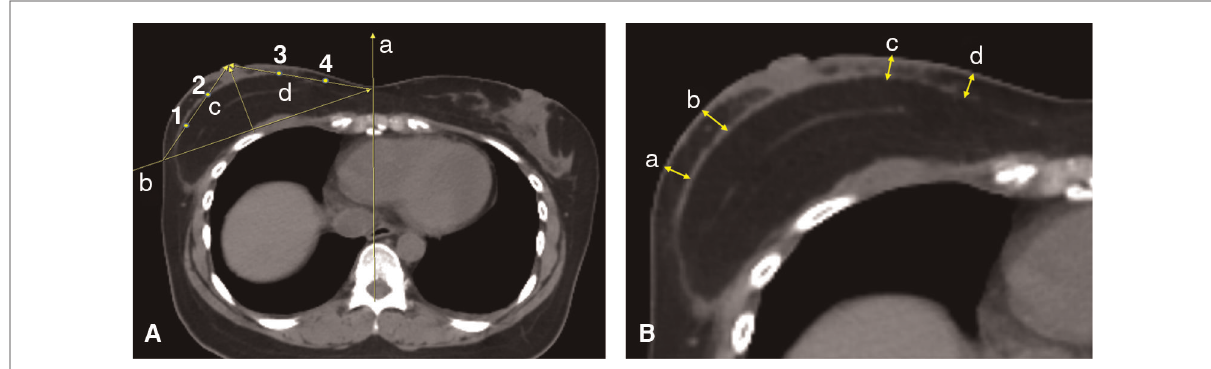
FIGURE 4 The graphical illustration of the fl ap thickness using CT scan: ( A ) (a) midsagittal line; (b) a line drawn from line “ a ” to the lateral pole of the breast through the outer surface of the rib cage; (c) a line connecting the center of the most projected point of the nipple to the crossing point of the line “ b ” with the breast skin at the lateral pole; (d) a line connecting the center of the most projected point of the nipple to the crossing point of the line “ b ” with the line “ a ” in the midline; (1) and (2) points that divide the line “ c ” into three equal lines; (3) and (4) points that divide the line “ d ” into three equal lines; ( B ) (a) and (b) the fl ap thickness measurement points on the lateral pole of the breast; (c) and (d) the point of fl ap thickness measurement on the medial pole of the